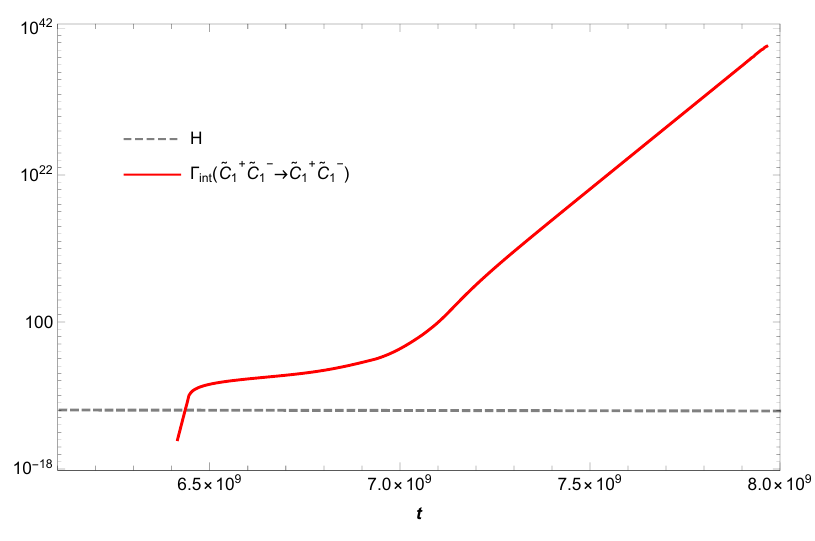
~ C (cid:0) ~ C (cid:0) ! ~ C + plotted against time (shown in units 1 1 1 1